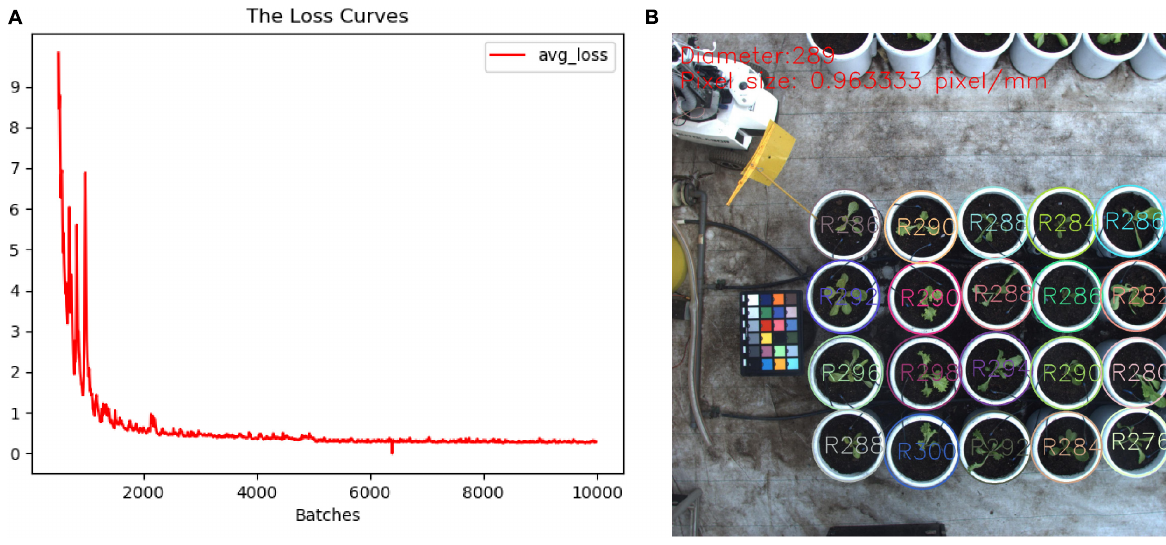
Frontiers in Plant Science |